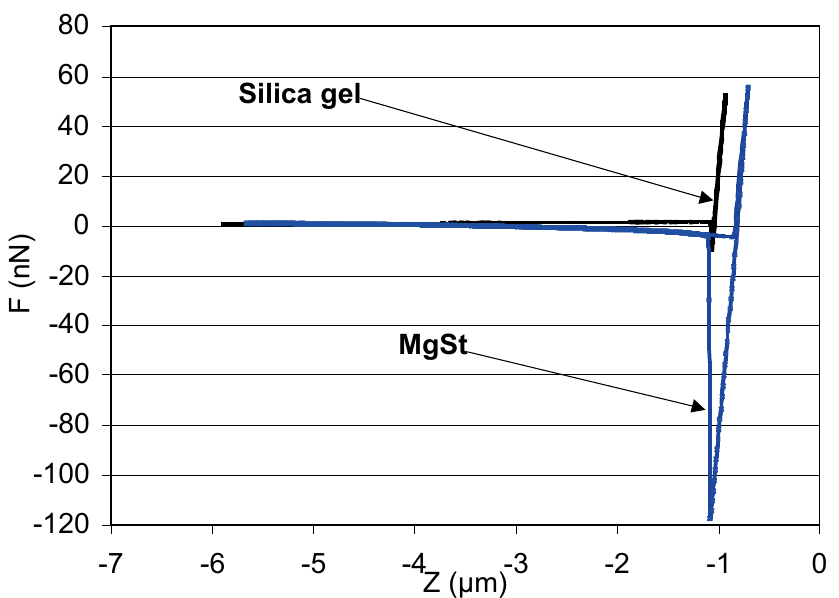
sticked on the tip for pure silica 2